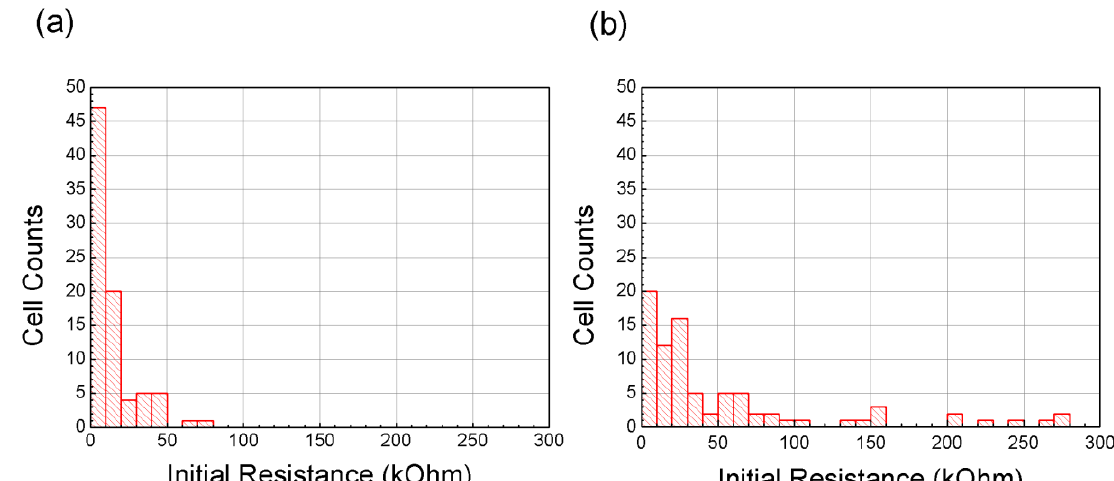
Figure 2. CNT network initial resistances. ( a ) Distribution of initial resistance for the bare CNT networks. ( b ) Distribution of initial resistance for the SnO